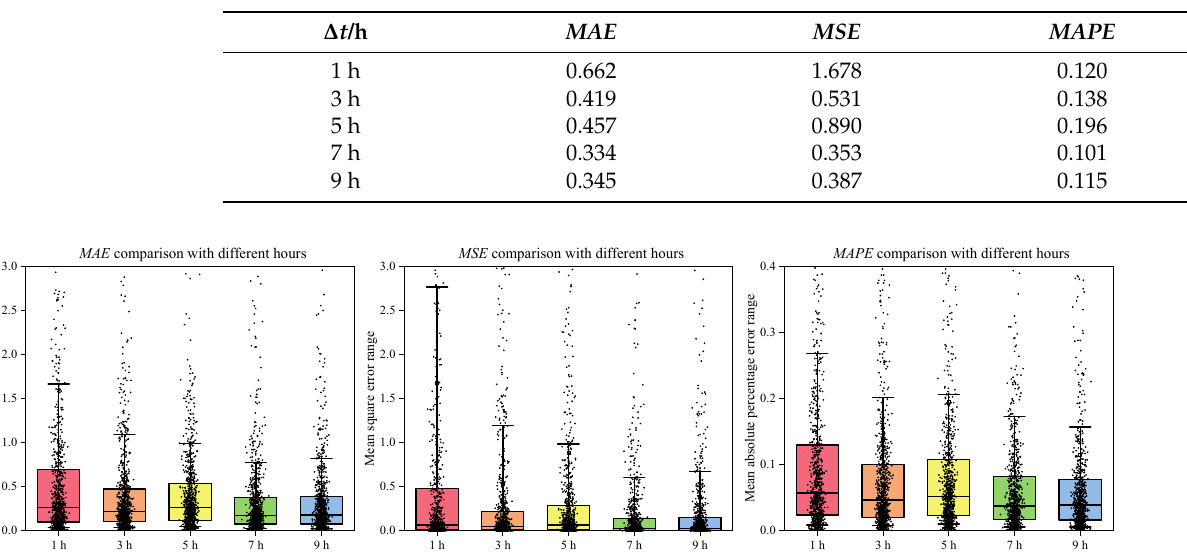
Table 3. Performance of the models when the size of the sliding window is 1 h, 3 h, 5 h, 7 h, and 9 h.